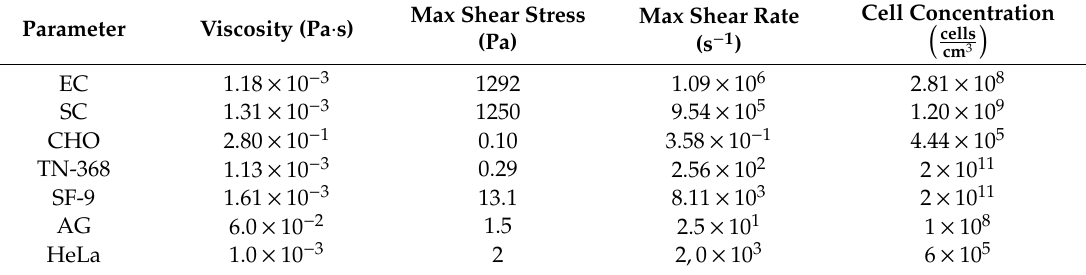
Table A3. Cells reference